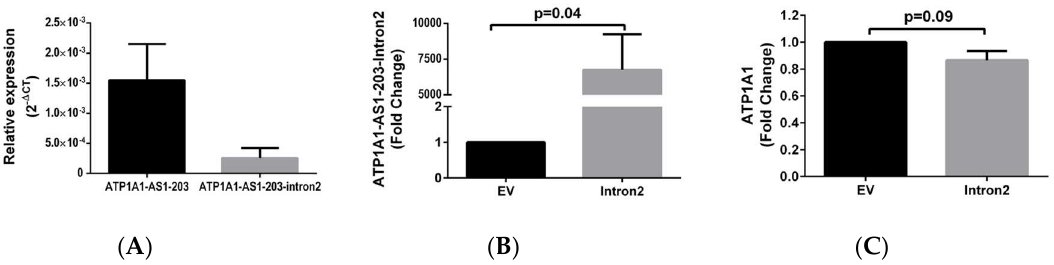
Figure 6. Effect of intron 2 of ATP1A1-AS1-203 on the expression of ATP1A1 in HK2 cells. ( A ) The expression level of ATP1A1-AS1-203 and ATP1A1-AS1-203 -Intron 2 in HK2 cells; ( B , C ) The effect of ATP1A1-AS1-203 -Intron 2 overexpression on ATP1A1 gene expression. The ATP1A1-AS1-203 -Intron 2 overexpression vector (Intron2) was transiently transfected into HK2 cells for 48 h and the total RNA extracted from the cell lysates were used for RT-qPCR measurement of ATP1A1-AS1-203 -Intron 2 ( B ) and ATP1A1 ( C ). These experiments were repeated four times. Data was analyzed using t -test.